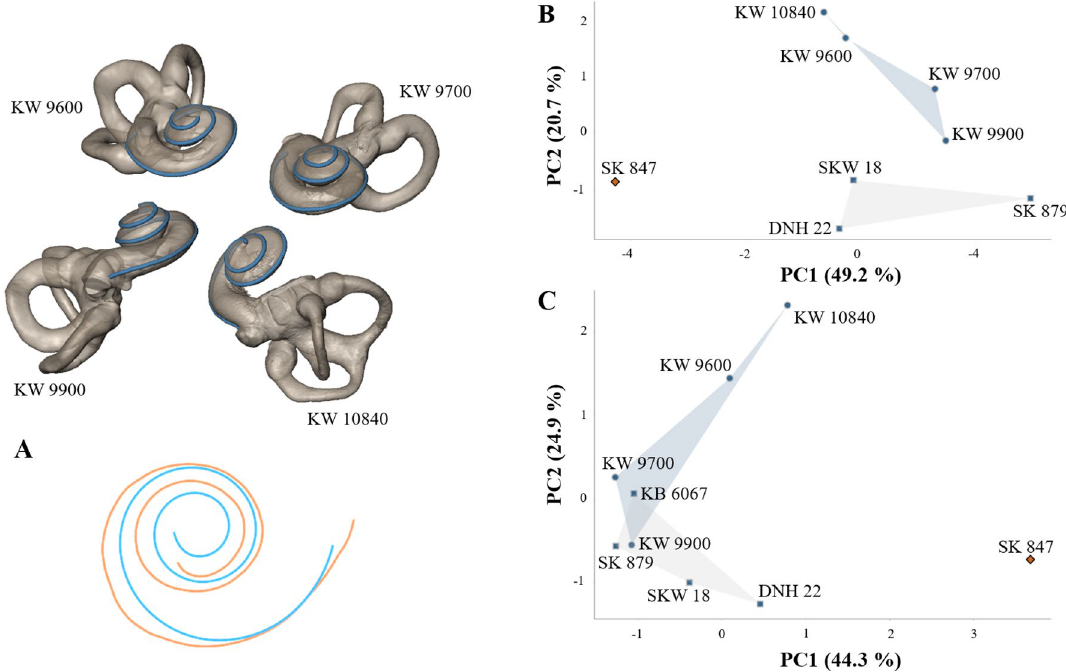
Figure 1. Four new fossil hominins recovered from Kromdraai (South Africa) attributed to Paranthropus robustus , and mean cochlear shape in this species . The new specimens from Kromdraai represent three juvenile (KW 9600, KW 9700 and 10840) and one adult (KW 9990) individuals (blue circles). Blue squares represent other P. robustus specimens from Kromdraai, Swartkrans and Drimolen. Only SK 847 is attributed to early Homo (orange diamond). ( A ) Fréchet mean computed from our P. robustus sample (blue) aligned with the cochlear curve of the SK 847 early Homo specimen (orange) using exactly the same reference system and orientation. ( B , C ) Two distinct principal components analyses (PCA, with the variance percentages indicated for PC1 and PC2) using ( B ) one data set with the two angles and the seven indices listed in Table S3